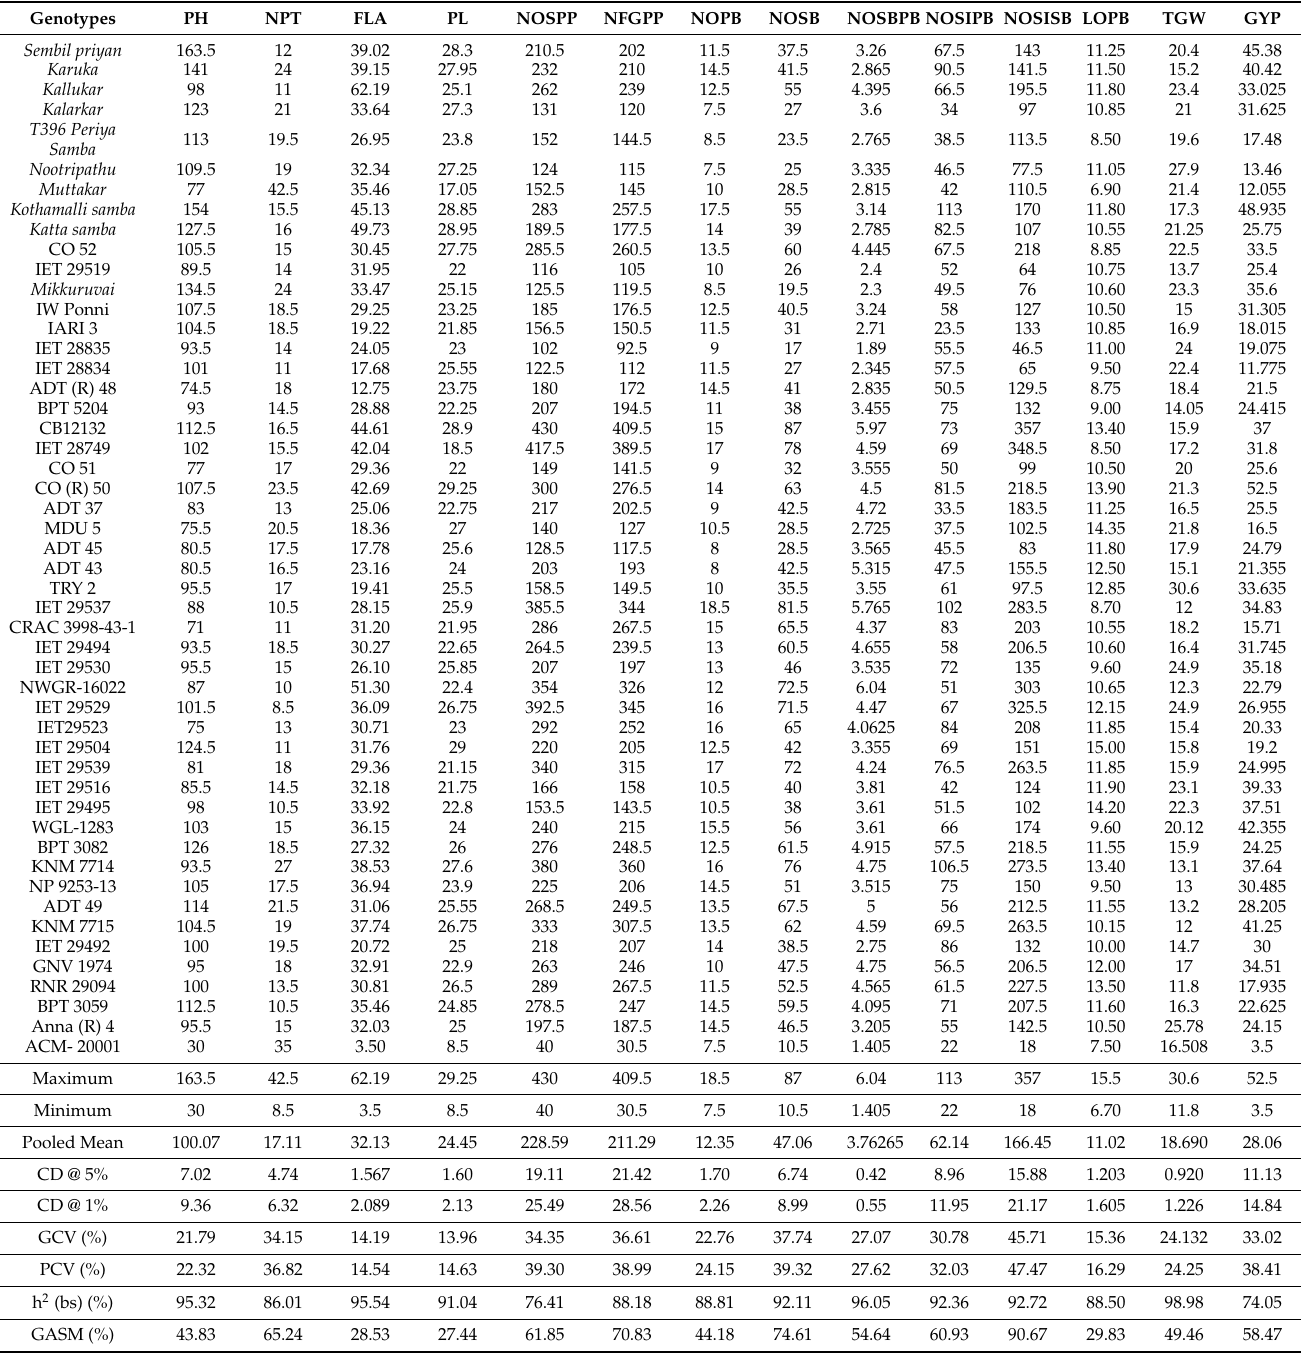
Table 1. Pooled estimates of mean and variability of fifty diverse rice genotypes for fourteen panicle- and yield-related